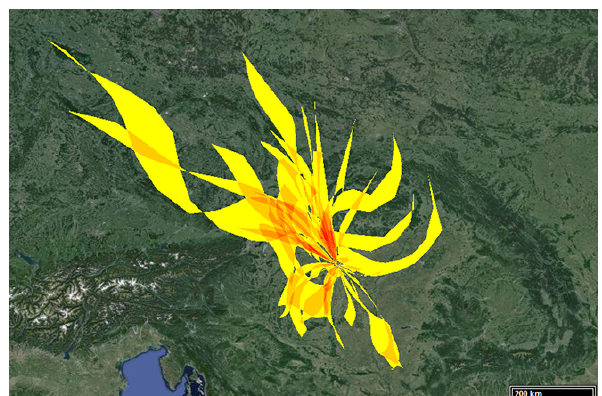
Figure 5. Arrival fields of nucleating air masses in the Carpathian Basin for the near-city background of Budapest. The overlapping sections were indicated in stronger shaded colours (from yellow through orange to red).